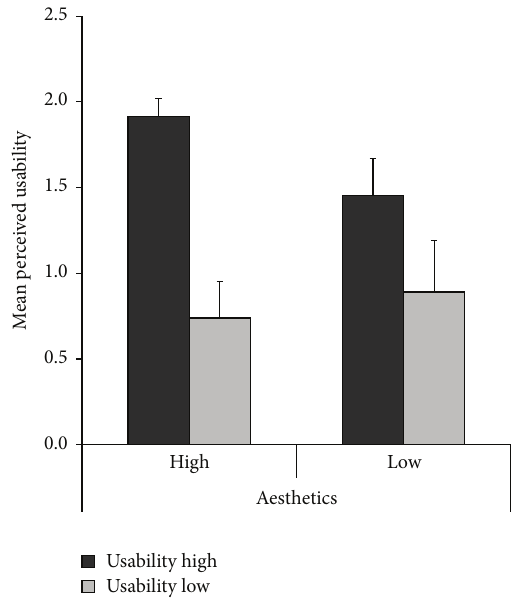
Figure 6: Mean rating of the perceived usability of the mobile depending on the mobile’s manipulated usability (high versus low) and the manipulated aesthetics (high versus low). Note that the scale ranges from − 3 to +3. Vertical lines indicate the standard error of the